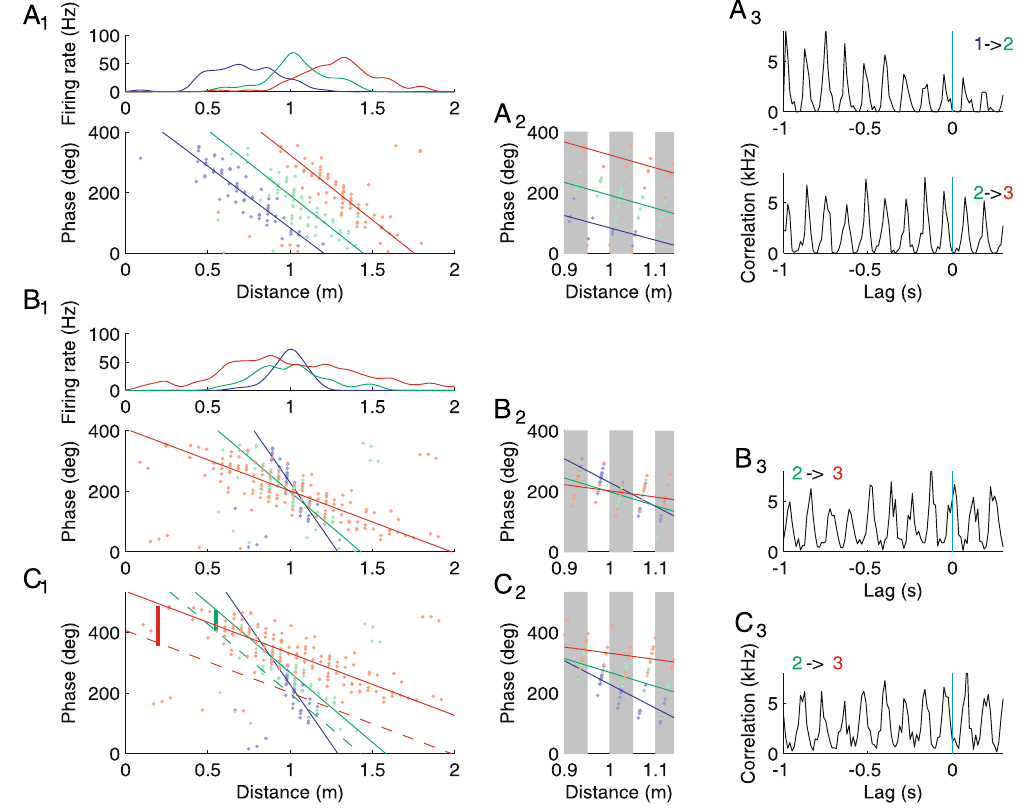
Figure 1. Phase precession and pairwise correlations in simulated place field activity. ( A 1 ) Spike phases and positions of three cells (colors) with same width and different centers. Top panel depicts firing rates as a function of position. Bottom depicts phase of spikes as a function of position. Solid lines are obtained from circular linear fits to the dots 34 . ( A 2 ) Close up of phase plot from A 1 at the place field center illustrating that in each theta cycle (grey and white columns) the temporal sequence of spikes (vertically increasing phase patterns) corresponds to ordered place fields: 1 before 2 before 3. ( A 3 ) Crosscorrelation functions exhibit systematic peak shifts on the theta time scale encoding the difference of the place field centers. The negative peak lags correspond to cell 1 firing before cell 2 and cell 2 firing before cell 3 as indicated by the labels (1 → 2, 2 → 3). ( B 1–3 ) Same as in A for three place cells with different widths and same center. Cells 2 and 3 fire at the same time on average. ( C 1–3 ) Data from B with a cell specific phase shift: The larger the field the more the phases are shifted upwards. Dashed lines are the linear fits from B 1 . Thick solid vertical lines indicate the theta phase offsets relative to the local theta oscillation of the blue cell: Theta oscillation is increasingly delayed for the green and the red cell. For details on the numerics see